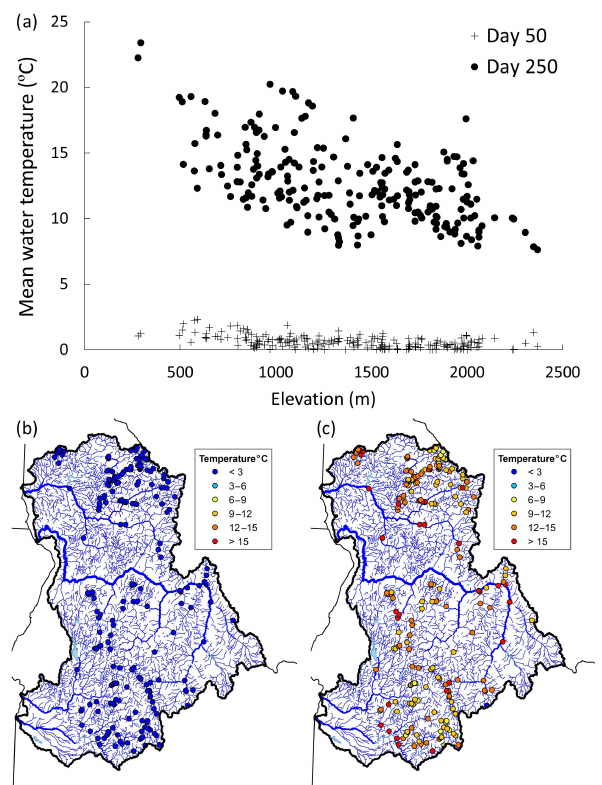
Figure 6. Thermal patterns during two periods with distinct spatial phases based on T-mode PCA results (a) . Day 50 occurs in mid- January and represents the homogenous winter period (b) , whereas day 250 occurs in late July and represents the heterogeneous pe- riod (c) .